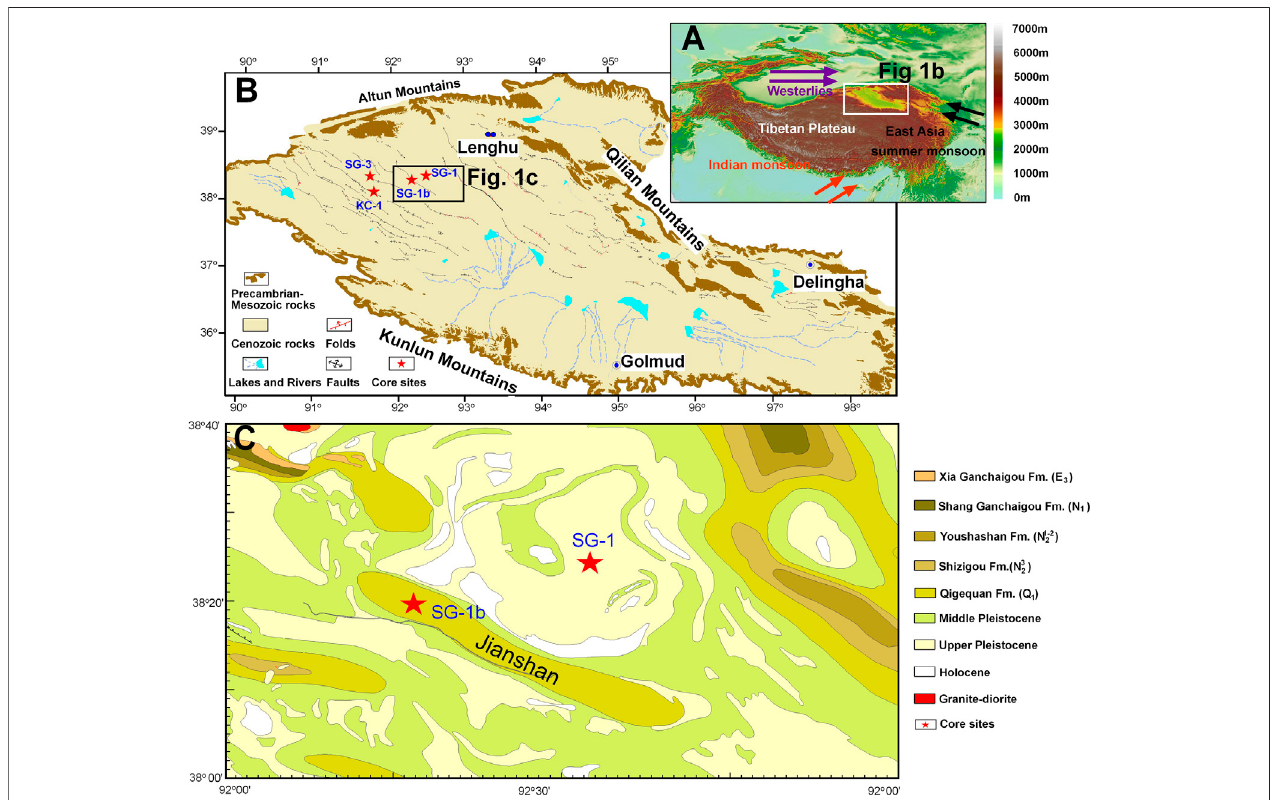
FIGURE 1 | (A) Topographic map of the Tibetan Plateau and Central Asia indicating the Qaidam Basin area. (B) Map of the Qaidam Basin and adjacent region showingthesurroundingmountains,majorstructures,andthestudyarea(modi fi edfromZhangetal.,2012a). (C) GeologicmapofthestudyareainthewesternQaidam Basin showing the locations of the SG-1b and SG-1 drill-sites (red asterisks) (modi fi ed from Zhang et al., 2012b).